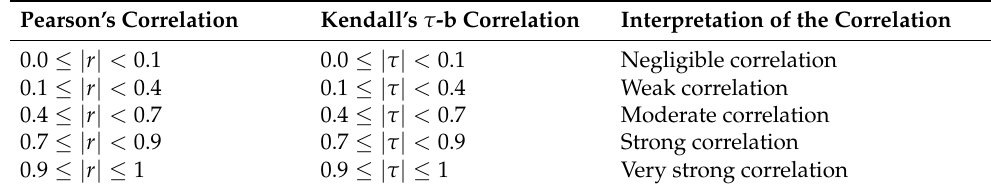
Table 8. Interpretation of Pearson’s and Kendall’s Correlation